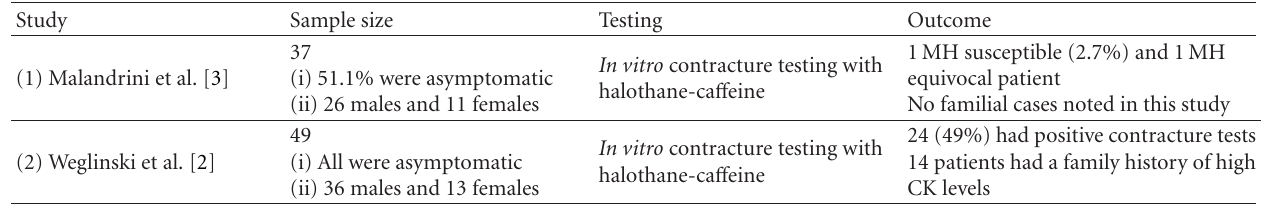
Table 1: Summary of 2 studies specifically studying the susceptibility of developing MH in patients with unexplained